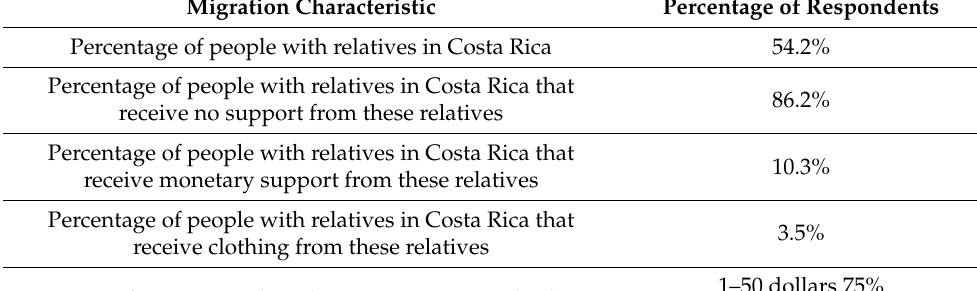
Table 6. Select migration and remittance responses from the 2001 Nicaragua